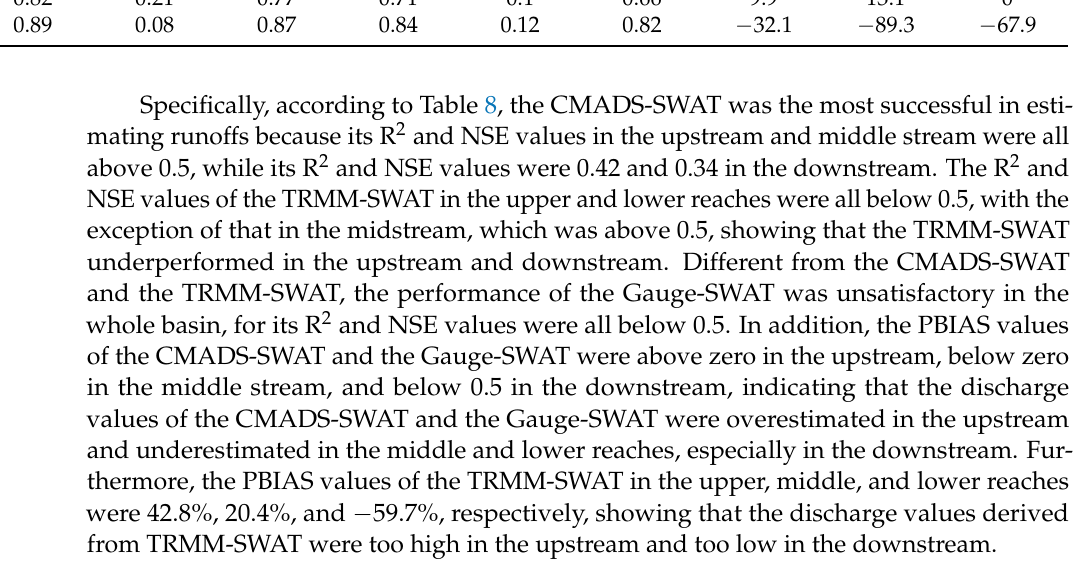
Table 8. The post-calibration performance error amounts of the SWAT model simulated with CMADS, TRMM, and Gauge data on a daily monthly